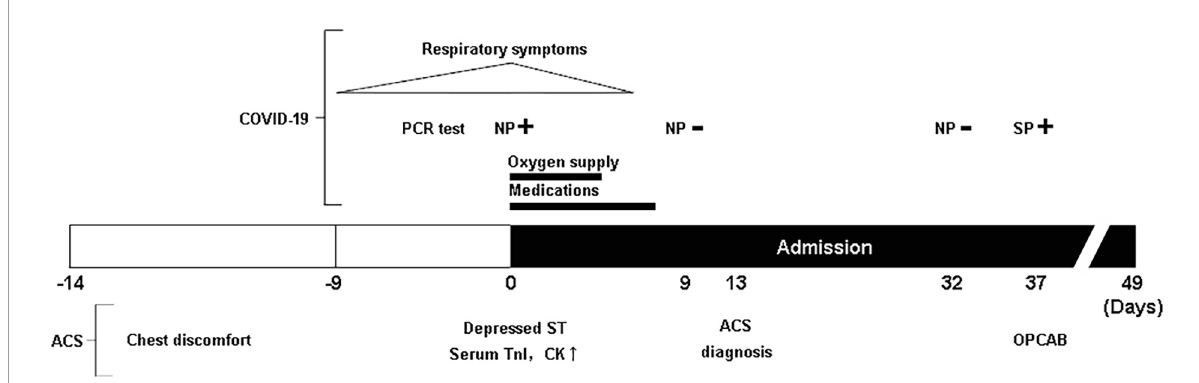
FIGURE1 A schematic view of the patient’s clinical history. NP, nasopharyngeal; SP, sputum through intubation tube; TnI, Troponin I; CK, creatine phosphokinase-MB isozyme.